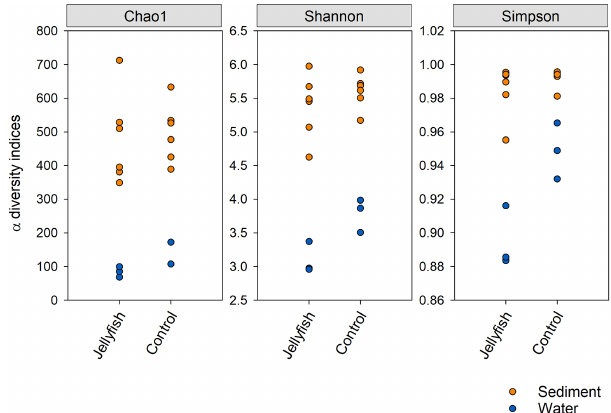
Figure 6. Bacterial alpha diversity indices (Chao, Shannon, Simp- son) in water and sediment samples from experimental cylinders enriched with carcasses of the jellyfish and in the controls ( N =